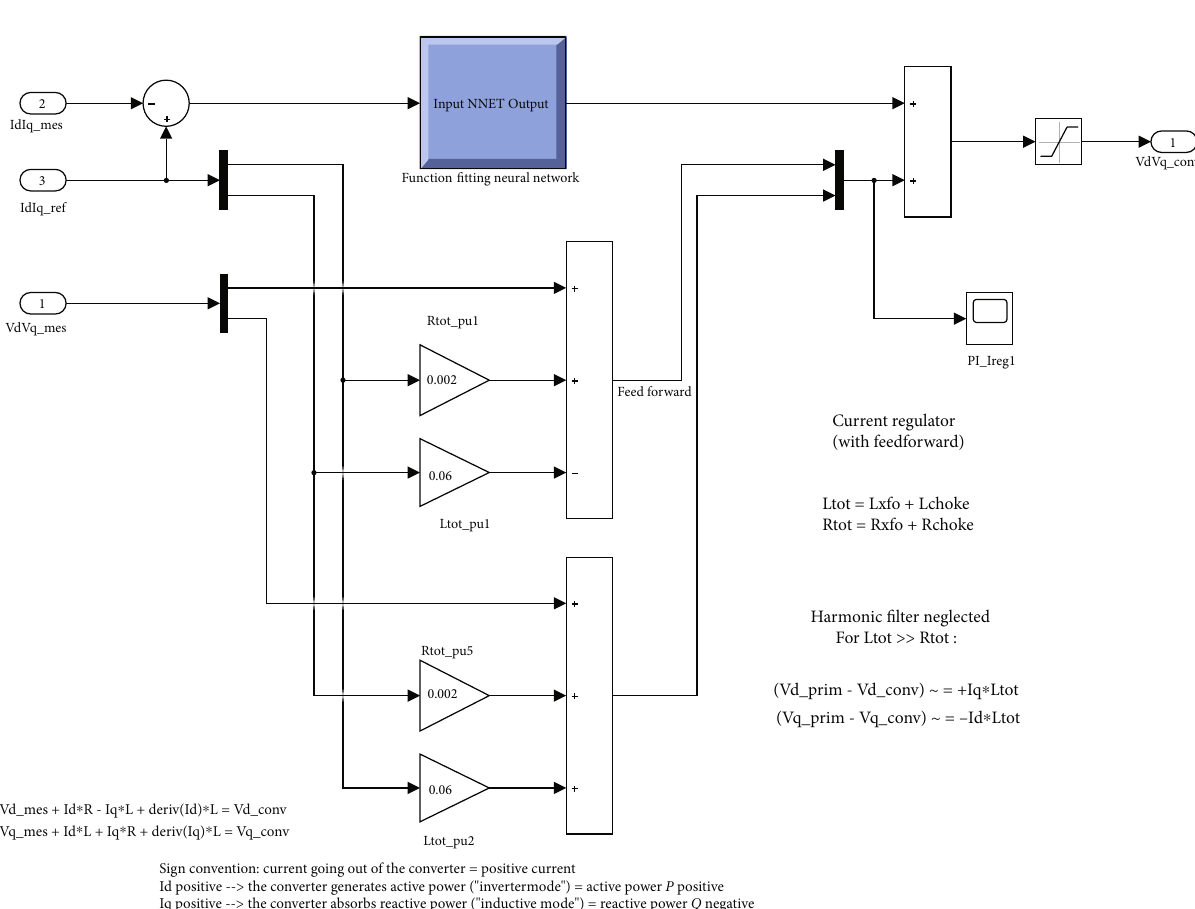
Figure 23: DNN-based current regulator for smart inverter.